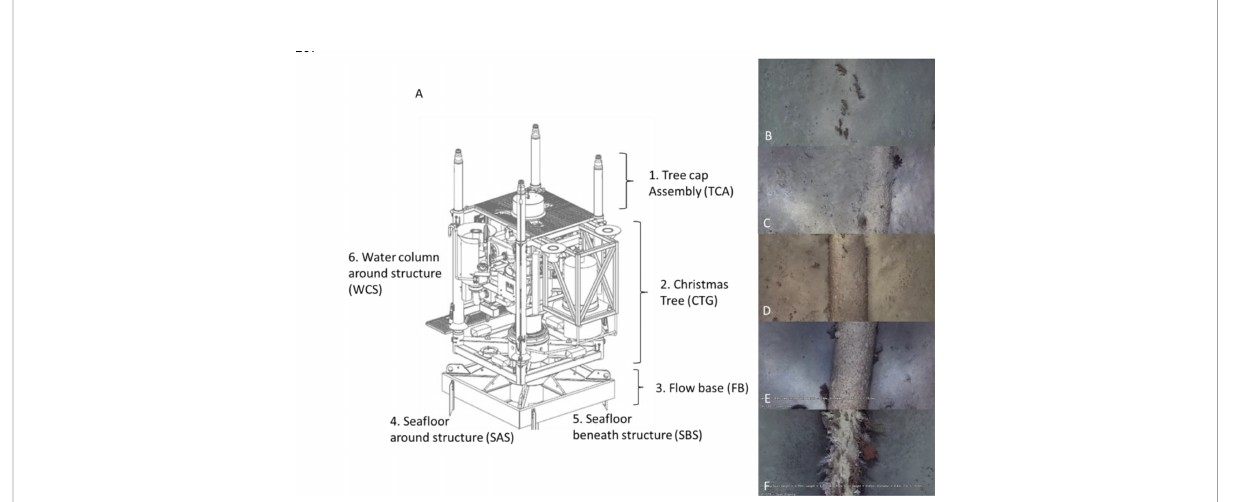
FIGURE 2 (A) Schematic of a subsea well (adapted from McLean et al., 2018) indicating the different sections for which separate measures of epibiota and abundance of fi shery target species were measured. The total abundance of all fi sh species was also obtained for the entire well (highest MaxN across the sections). (B – F) Features of pipelines assessed from ROV imagery including the extent of burial/spanning ( “ pipeline position ” ) ranging from completely buried (0 = A) to more than half buried (1 = B), resting on sea fl oor (2 = C), underside of pipeline not touching sea fl oor (3 = D), and pipeline span >0.5 m above sea fl oor (4 =